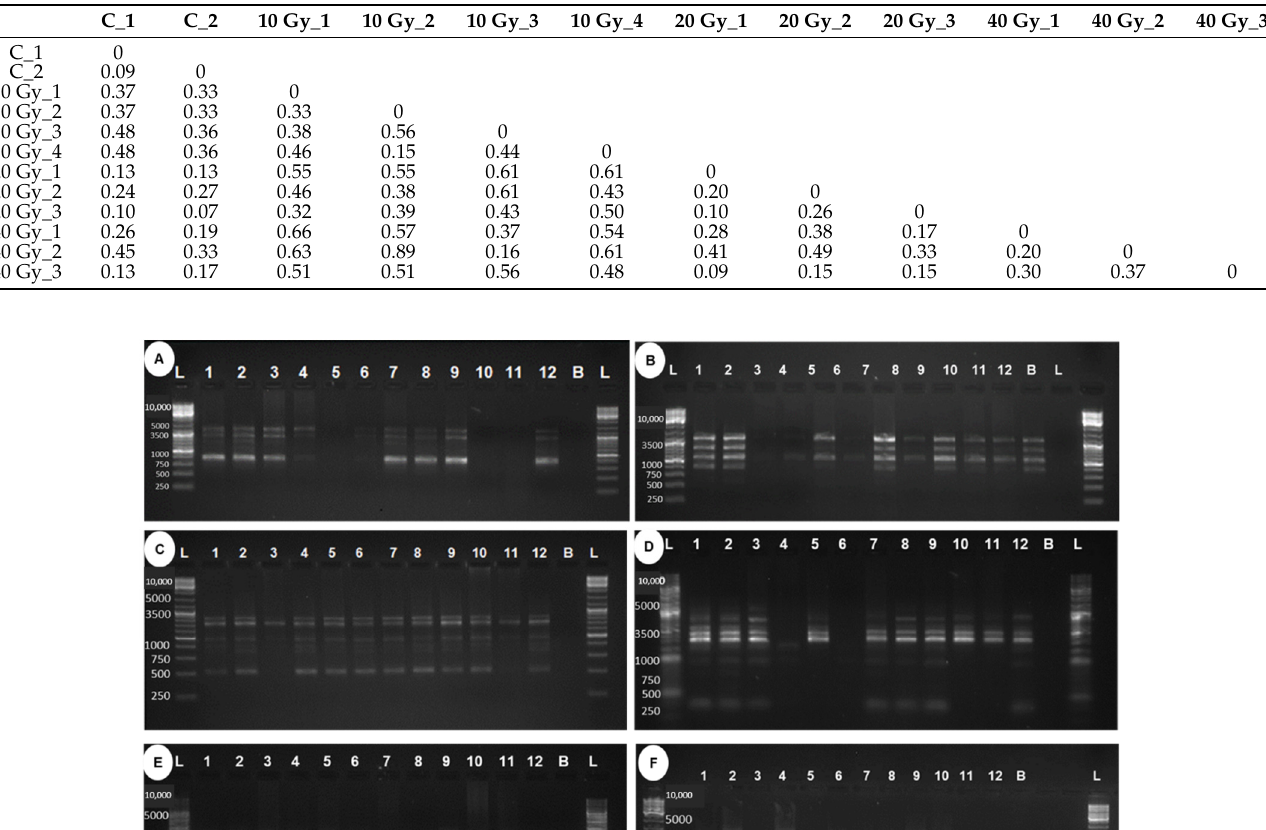
Table 4. Genetic dissimilarity matrix from random amplified polymorphic DNA binary data of gamma-ray-induced mutants of Dendrobium ‘Emma White’.